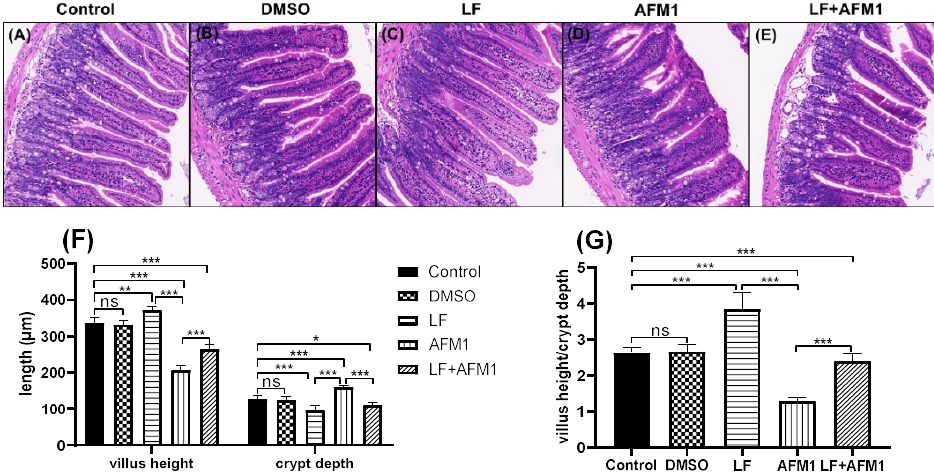
Figure 2. The effects of LF and AFM1 on mice ileum histology. Histology of the ileum was assessed by hematoxylin-eosin staining (HE, 200 × ). ( A ) Control mice (physiological saline), ( B ) DMSO-treated mice (1%DMSO/99% corn oil), ( C ) LF-treated mice, ( D ) AFM1 treated mice, ( E ) LF + AFM1 treated mice, ( F ) Villus height and crypt depth in mice ileum, ( G ) the ratio of villus height/crypt depth. Values represent the means ± SEM ( n = three animals). * represents p < 0.05, ** represents p < 0.01, *** represents p <